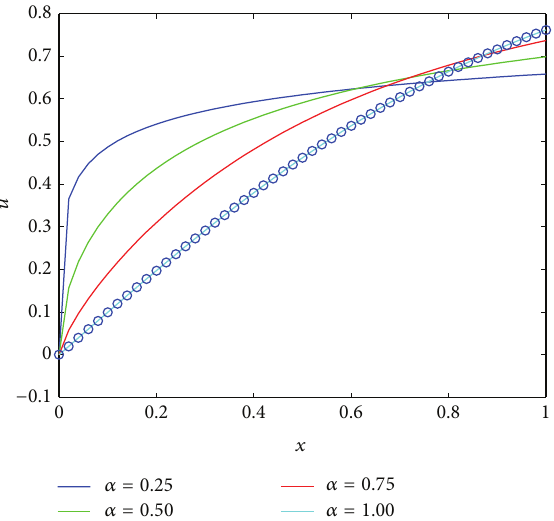
Figure 2: Numerical solutions for Example 11.